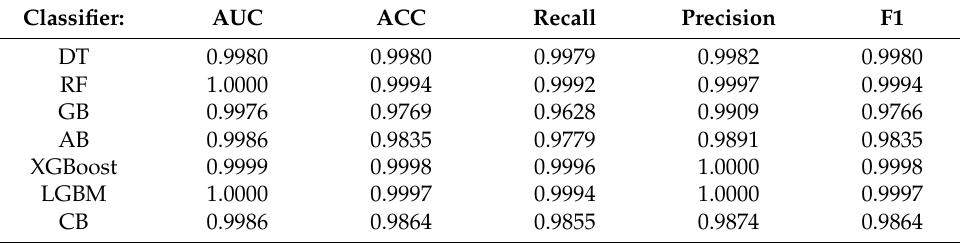
Table 8. Experiment III: Testing results of the classifiers after SMOTE algorithm using selected features.